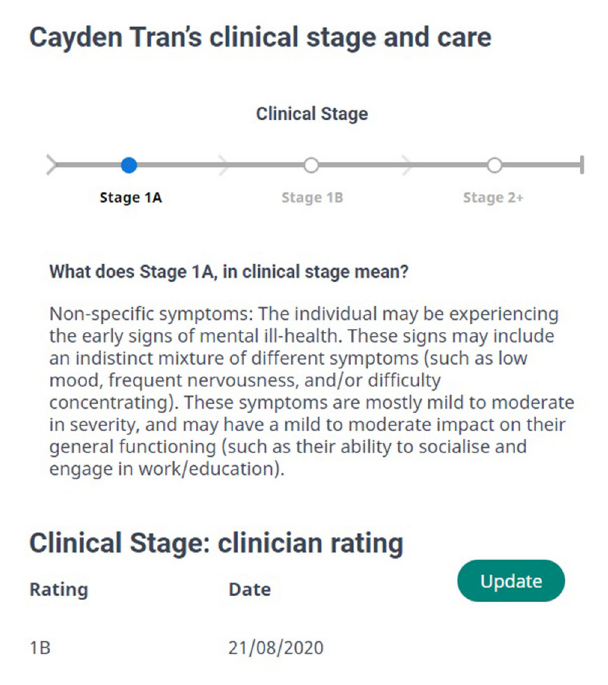
FIGURE 2 | A (fictional) young person’s suggested clinical stage from our automated protocol, and the clinician’s initial assessment of clinical stage (in this case disagreeing with the